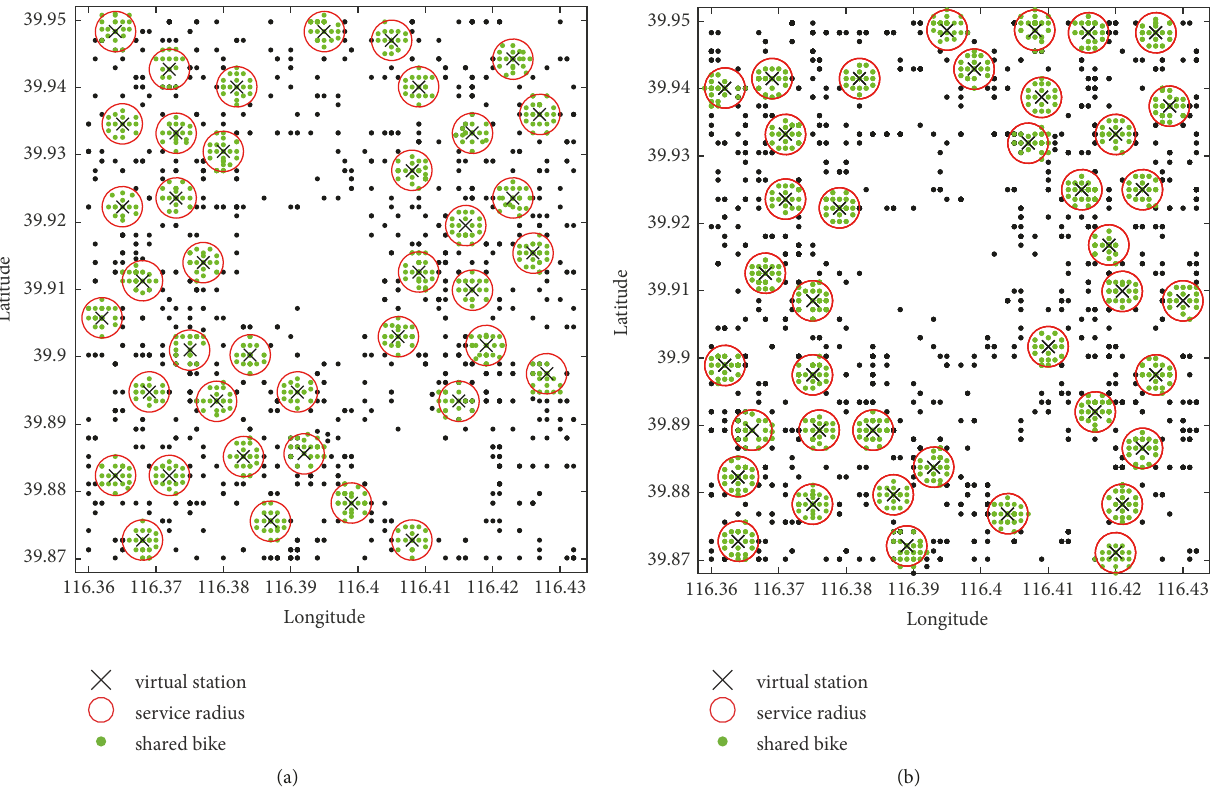
Figure 6: Best solution for location of virtual stations of FFBSSs during morning and evening rush hours.